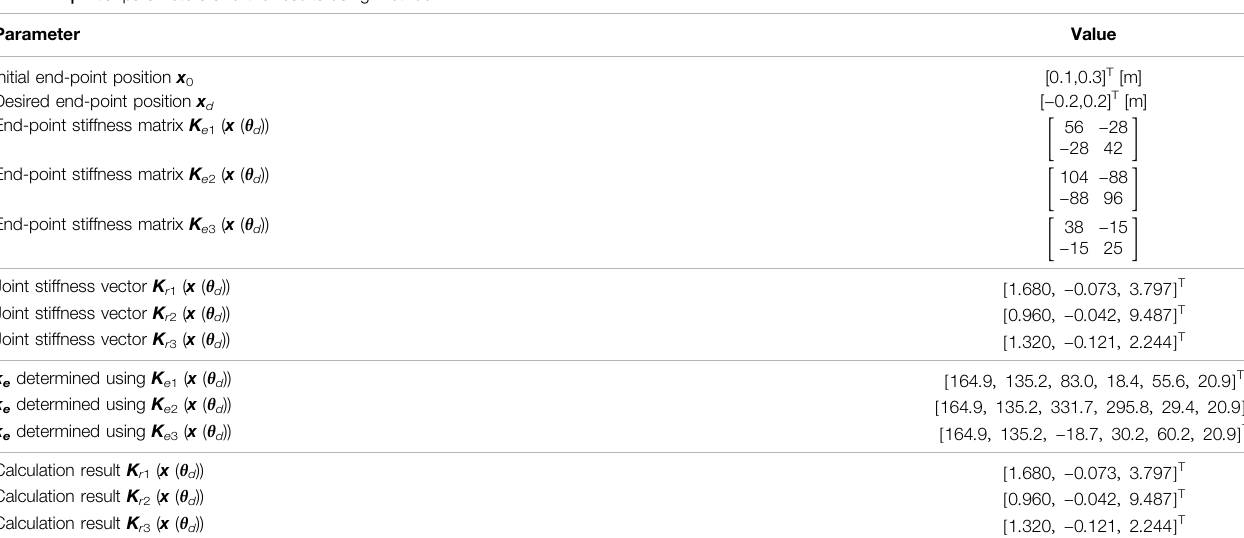
TABLE 2 | Initial parameters and the results using Method